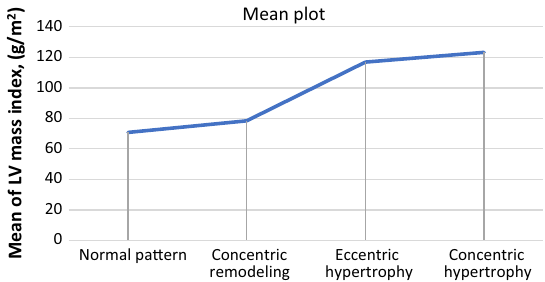
Normal pa(cid:17)ern Concentric remodeling Fig. 5 Comparison of the four LV geometric patterns regarding the LV mass index